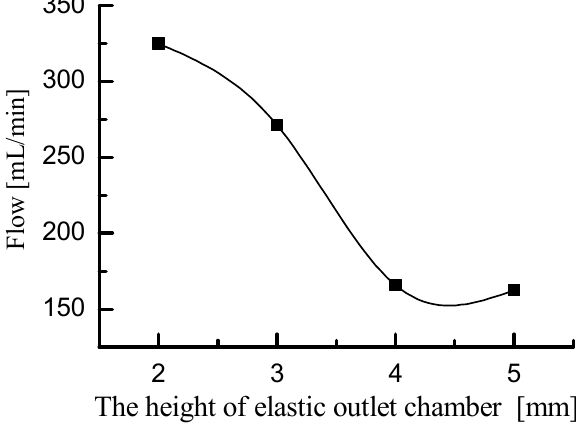
Figure 9. The flow rate at port B corresponding to different heights of elastic outlet cavity.